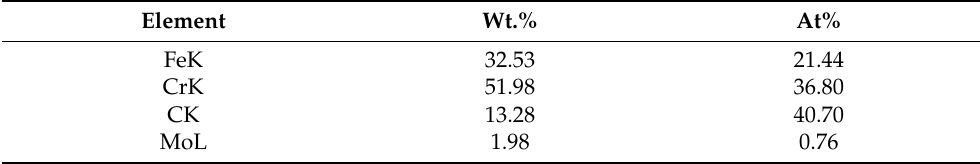
Figure 9. EDS result of the cracked zone in specimen #4.